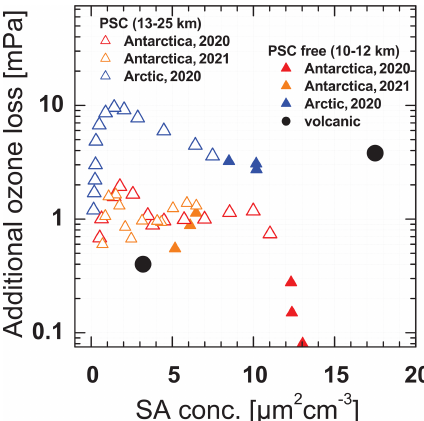
Figure 13. Arctic (NP2020, North Pole, January–February 2020) and Antarctic (PA2020, PA2021, Punta Arenas, June–August 2020, 2021) wildfire smoke layers in terms of particle surface area (SA) concentration. The background aerosol SA concentration is given as well (Sakai et al., 2016). For comparison, SA concentrations observed a few months after the minor Calbuco volcanic erup- tion (small circles, derived from satellite observations at 55 ◦ S, July 2015) (Zhu et al., 2018) and about 1.5 years after the major Pinatubo volcanic eruption (big circles, mean SA concentrations for the height range indicated by vertical bars, 53.4 ◦ N, Germany, spring 1993) (Ansmann et al., 1996) are included. PSC occurrence height ranges (open vertical bars to the left) for the Arctic (NP2020, blue) and Antarctic winter seasons (PA2020, red, PA2021, orange) are given as well.